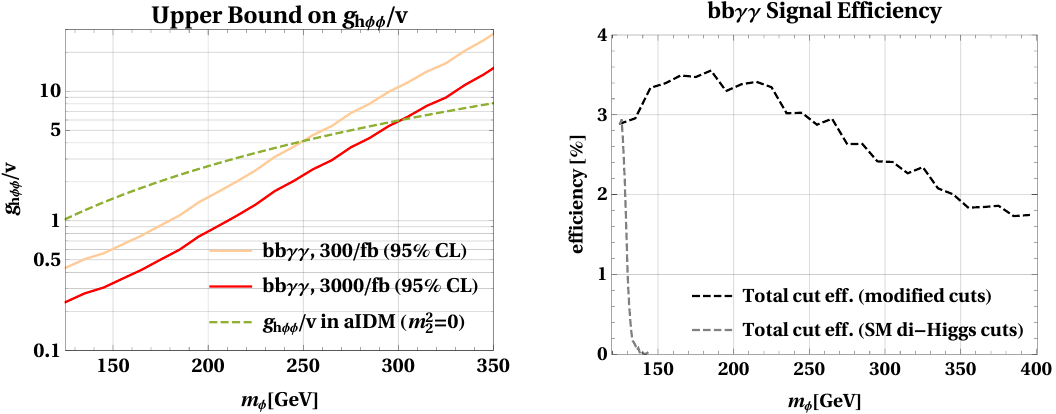
Figure 5. Left panel shows the upper limits on g h(cid:30)(cid:30) =v from pp ! h ! (cid:30)(cid:30) ! ( b (cid:22) b )( (cid:13)(cid:13) ) at the LHC with 300 fb (cid:0) 1 and HL-LHC (3000 fb (cid:0) 1 ). We also include the value of g h(cid:30)(cid:30) =v in aIDM for m 2 which is given by 4 m 2 =v 2 . Right panel shows the signal e(cid:14)ciency with the cuts from ref. [43] and (cid:30) using m (cid:30) -dependent invariant mass